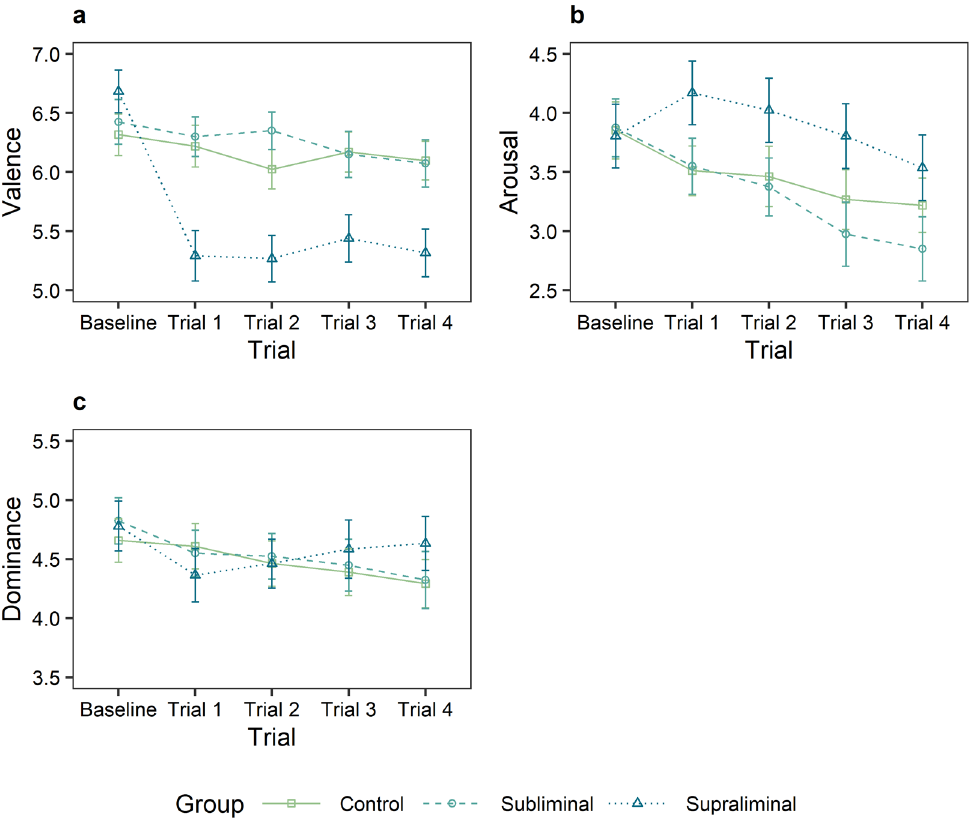
Figure 1. SAM ratings depending on trial and group affiliation. ( a) Valence ratings, ( b) arousal ratings, ( c) dominance ratings. Error bars correspond to the standard error of the mean.